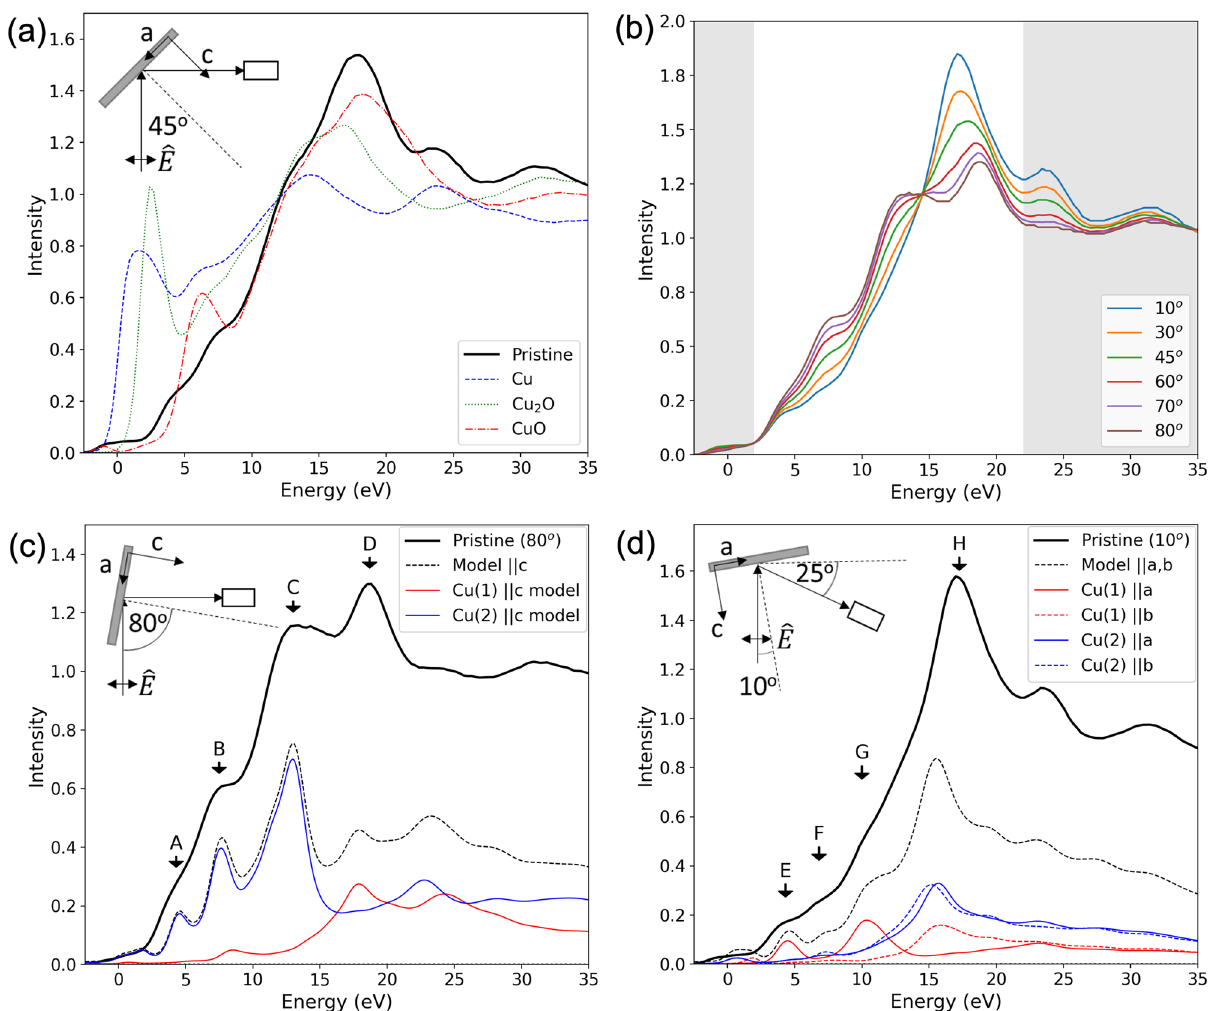
Fig. 4 Cu K-edge XANES spectra for pristine samples. a Comparison of XANES spectra taken from the pristine REBCO coated conductor with polycrystalline Cu foil, Cu 2 O powder and CuO powder standards. All data taken with the incident beam at 45° to the sample normal. Following the method in Heald et al. 12 , the energy calibration has been performed by setting zero energy to the fi rst peak in the fi rst derivative of the spectrum from the Cu foil standard. b Orientation-dependent XANES spectra for the pristine REBCO sample. Comparisons of the 80° and 10° experimental data from the pristine sample with ^ E jj c and ^ E jj a / b modelled spectra calculated by DFT are shown in c and d , respectively. Insets show schematic diagrams of the experimental